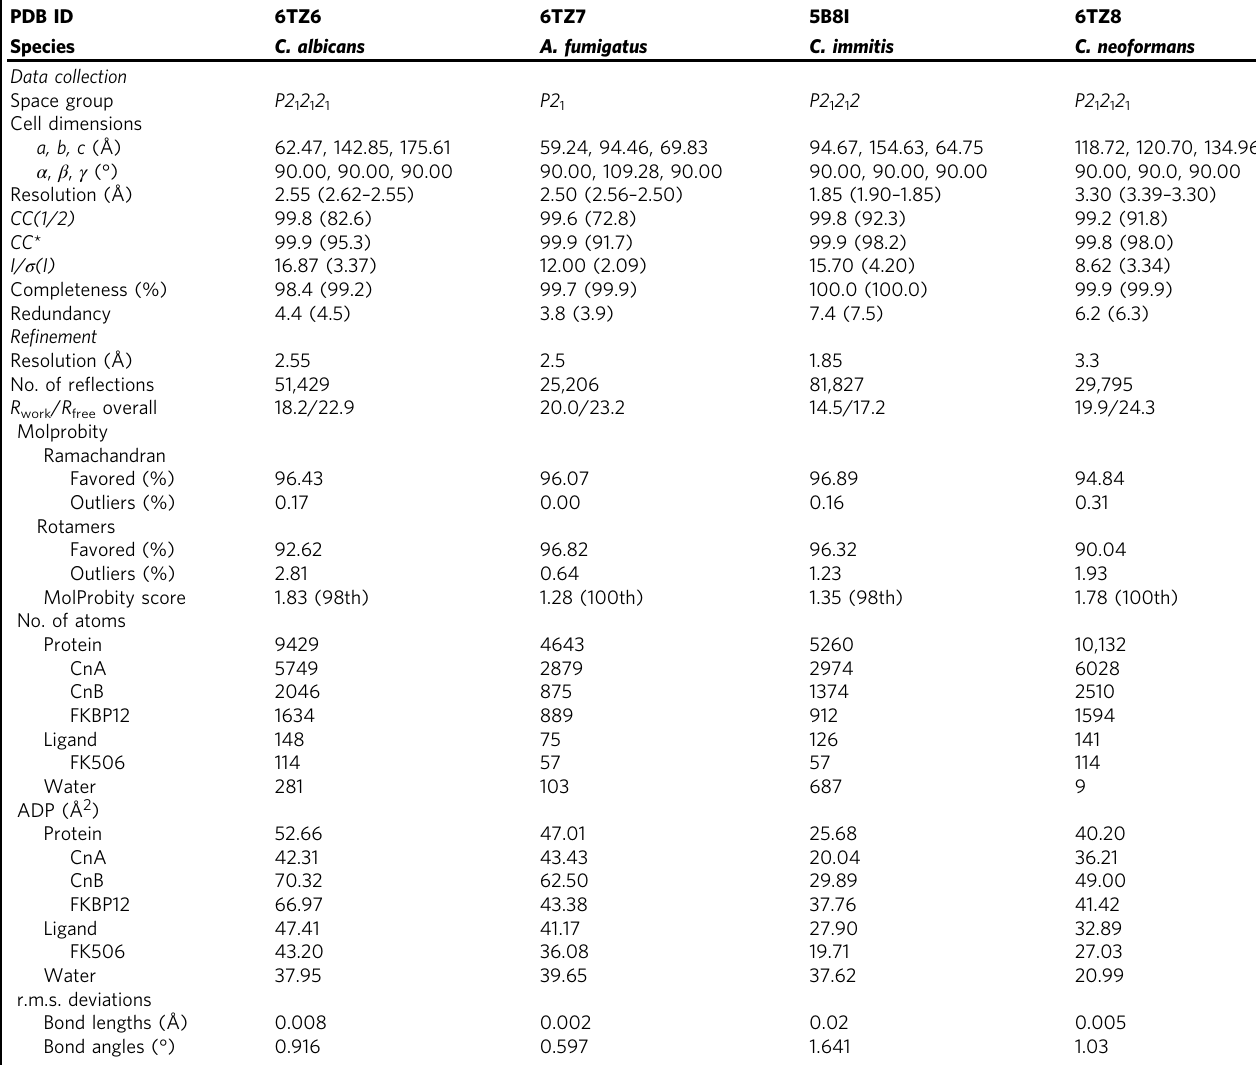
Table 1 Crystallography and structure re fi nement statistics of calcineurin ternary complexes from pathogenic